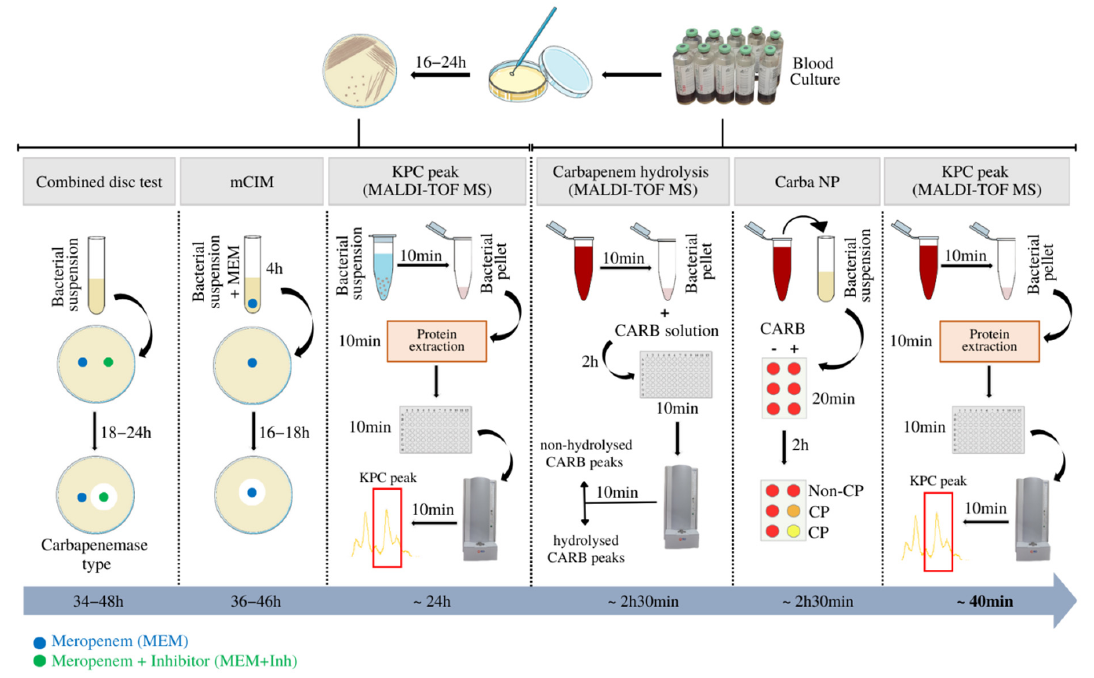
Figure 3. Turnaround time of available alternative methods to detect carbapenemase